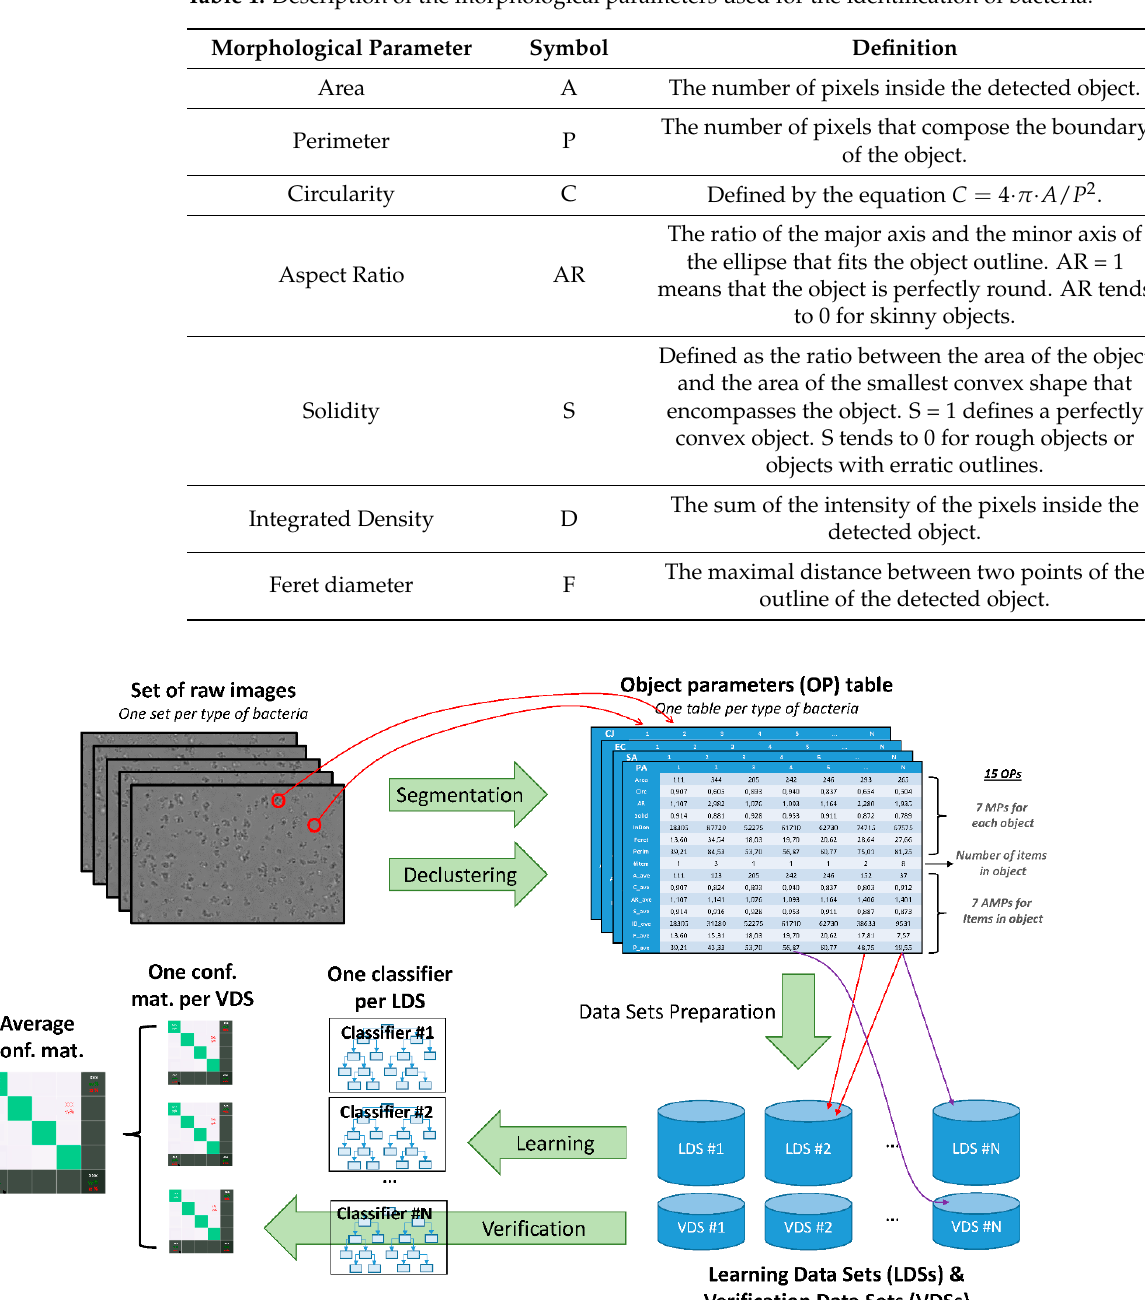
Table 1. Description of the morphological parameters used for the identification of bacteria.